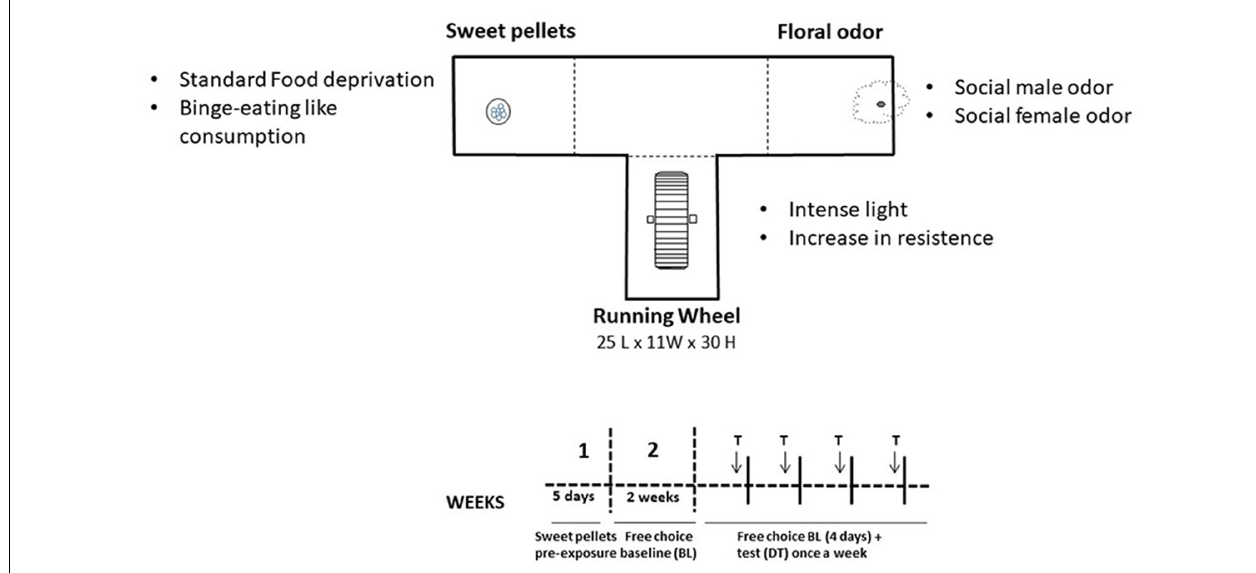
FIGURE 1 | Schematic representation of the three-choice T-maze task settings and timeline for the different experimental phases for the tetrabenazine (TBZ)